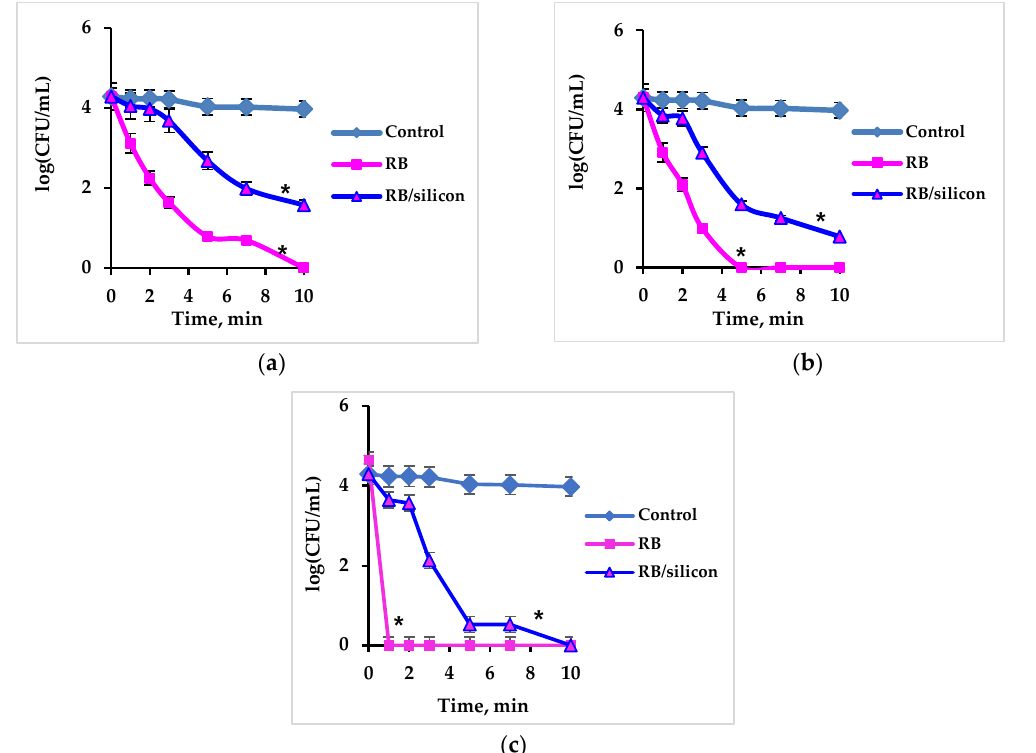
Figure 4. Comparison between the antibacterial activity of free Rose Bengal (designated RB) at concentrations of ( a ) 0.020 ± 0.001 mg/mL, ( b ) 0.030 ± 0.005 mg/mL, and ( c ) 0.050 ± 0.003 mg/mL with immobilized Rose Bengal (designated RB/silicon) when the concentrations of the released Rose Bengal at the end of the experiment reached: ( a ) 0.020 ± 0.004 mg/mL, ( b ) 0.030 ± 0.006 mg/mL, and ( c ) 0.050 ± 0.007 mg/mL under ultrasonic treatment in the dark. Initial concentration of S. aureus was 2 × 10 4 CFU/mL. Control cells were treated by ultrasound only. Error bars present standard deviations. The asterisk ( * ) denotes statistically significant differences with the control ( p < 0.05).